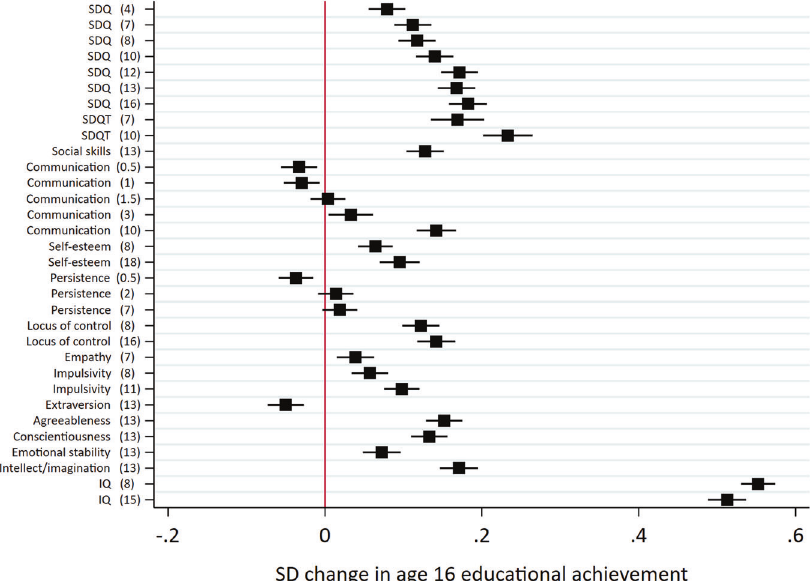
Fig. 3 Associations between skills and educational achievement at age 16. All skills and educational achievement were standardised to have mean zero and standard deviation one. Models for noncognitive skills include sex, month of birth and IQ at age 8 as controls. Models for IQ include sex and month of birth as controls. Educational achievement measured as exam point score at age 16. Age (years) in parentheses. SDQ: parent reported strengths and dif fi culties questionnaire; SDQT: teacher reported strengths and dif fi culties questionnaire.